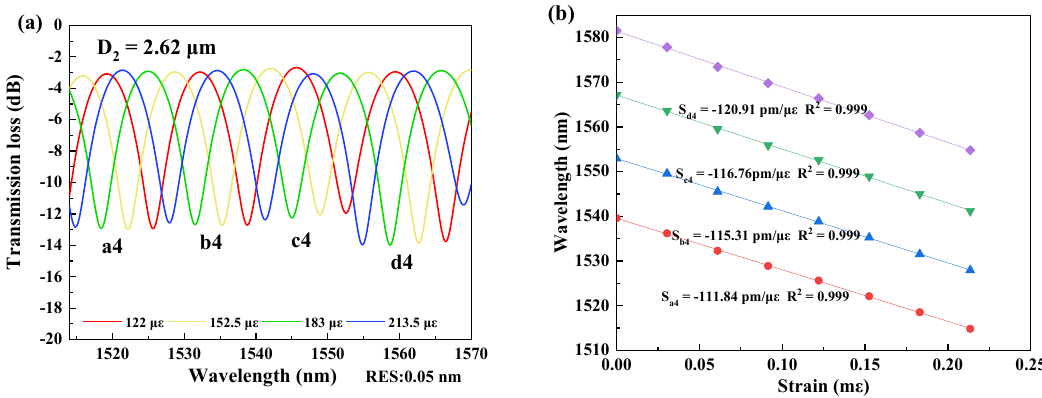
Figure 6. ( a ) Spectral responses of the interferometer with D 2 = 2.62 µ m at the strain ranging over